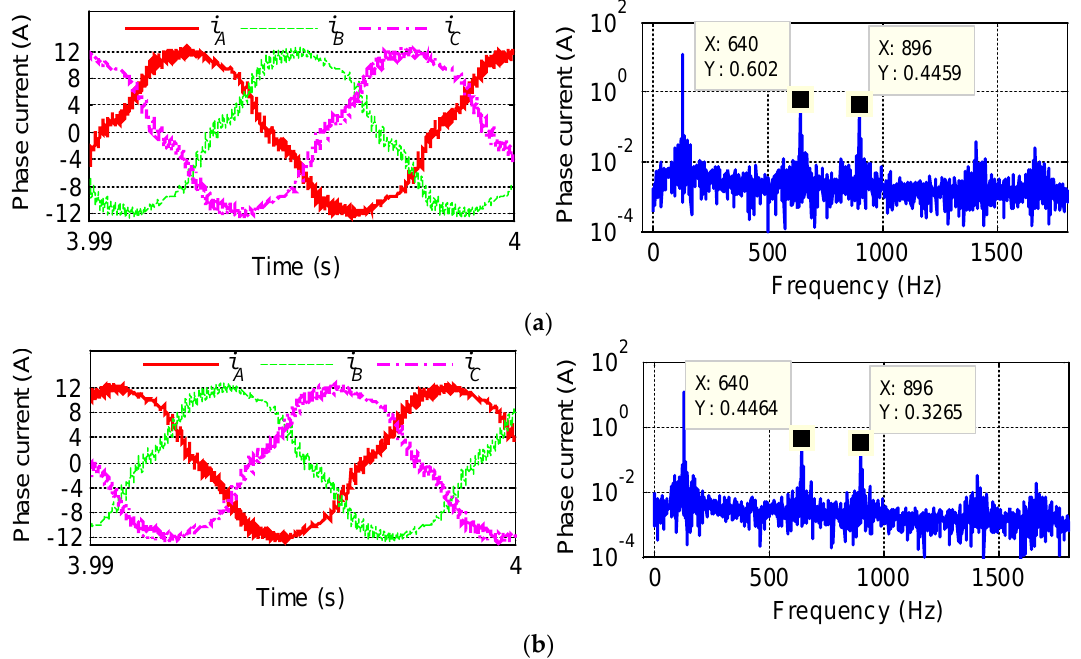
Figure 16. Waveforms and Fast Fourier Transform (FFT) results of phase current at 1920 r/min: ( a ) Before suppression; ( b ) After suppression.